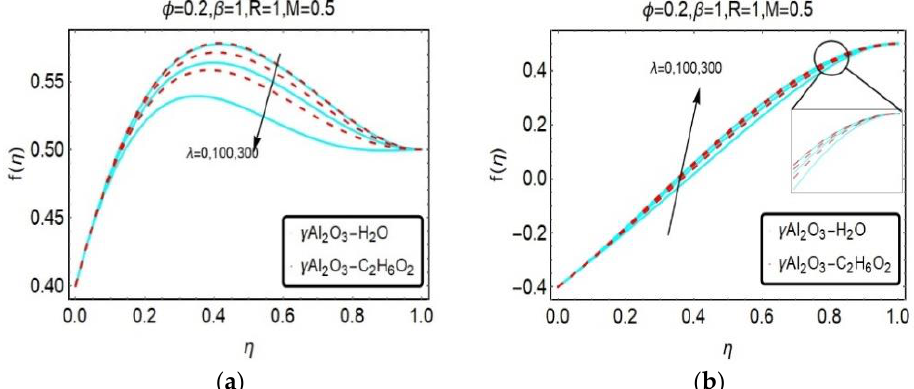
Figure 4. Influence of M 2 on f ( η ) for ( a ) S > 0 and ( b ) S < 0. Energies 2020 , 13 , x FOR PEER REVIEW